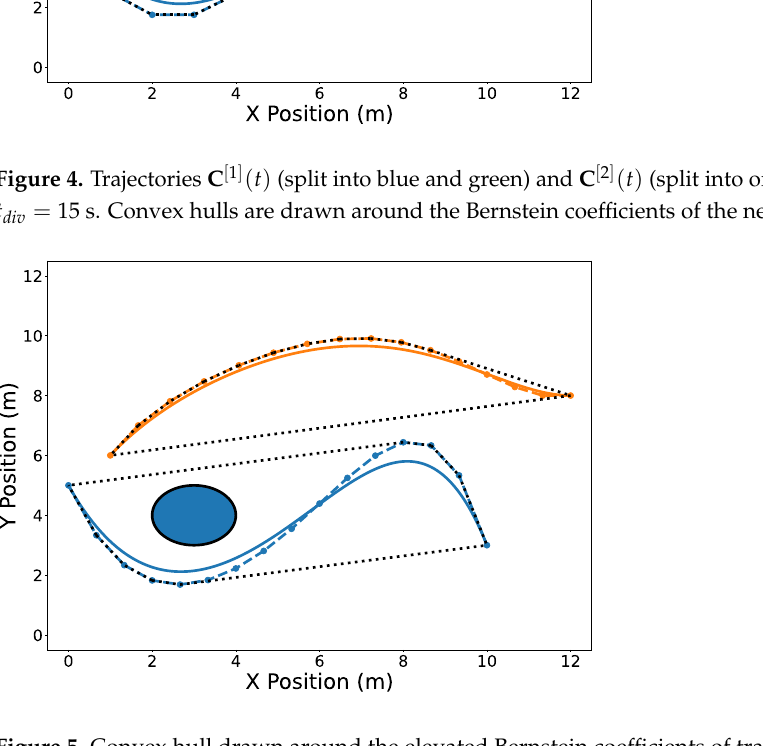
Figure 5. Convex hull drawn around the elevated Bernstein coefficients of trajectories C [ 1 ] ( t ) (blue) and C [ 2 ] ( t )